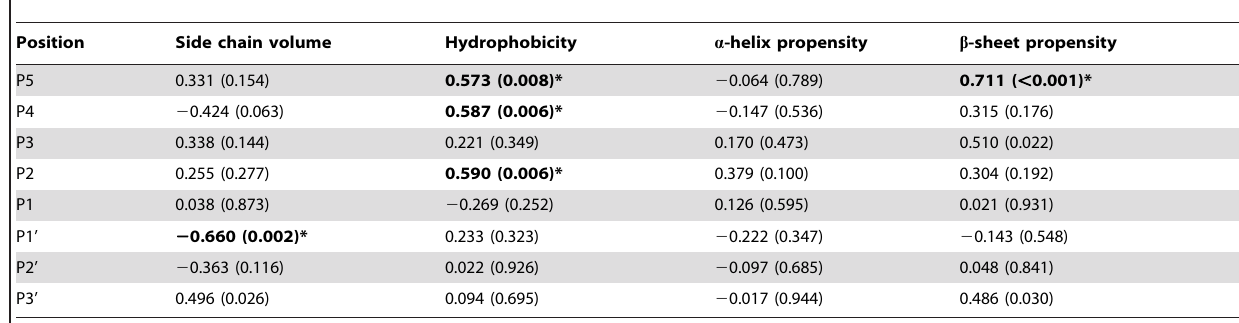
Table 1. Correlation between SARS-CoV 3CL pro activity and structural properties of substituting residues.